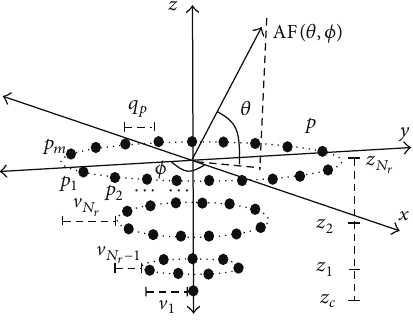
Figure 1: Volumetric ring antenna array.